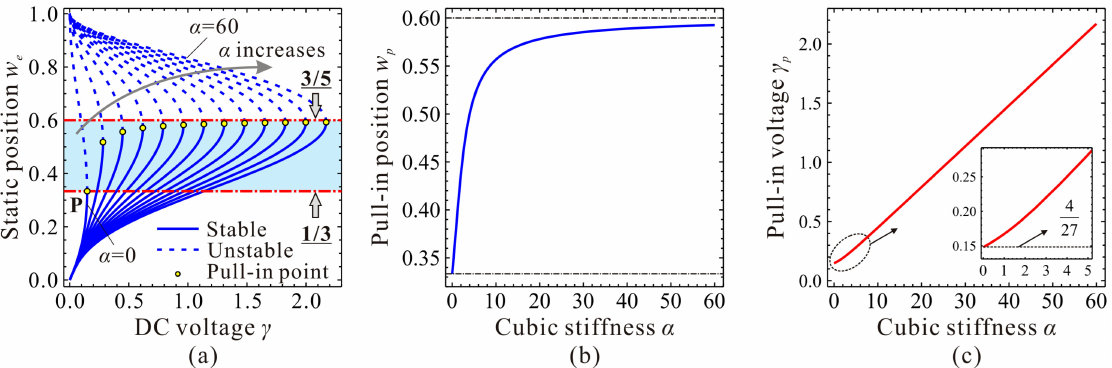
Figure 3. A detailed observation of the static position w e for different cubic stiffness α . global view ( a ); pull-in position w p ( b ); pull-in voltage γ p ( c ).